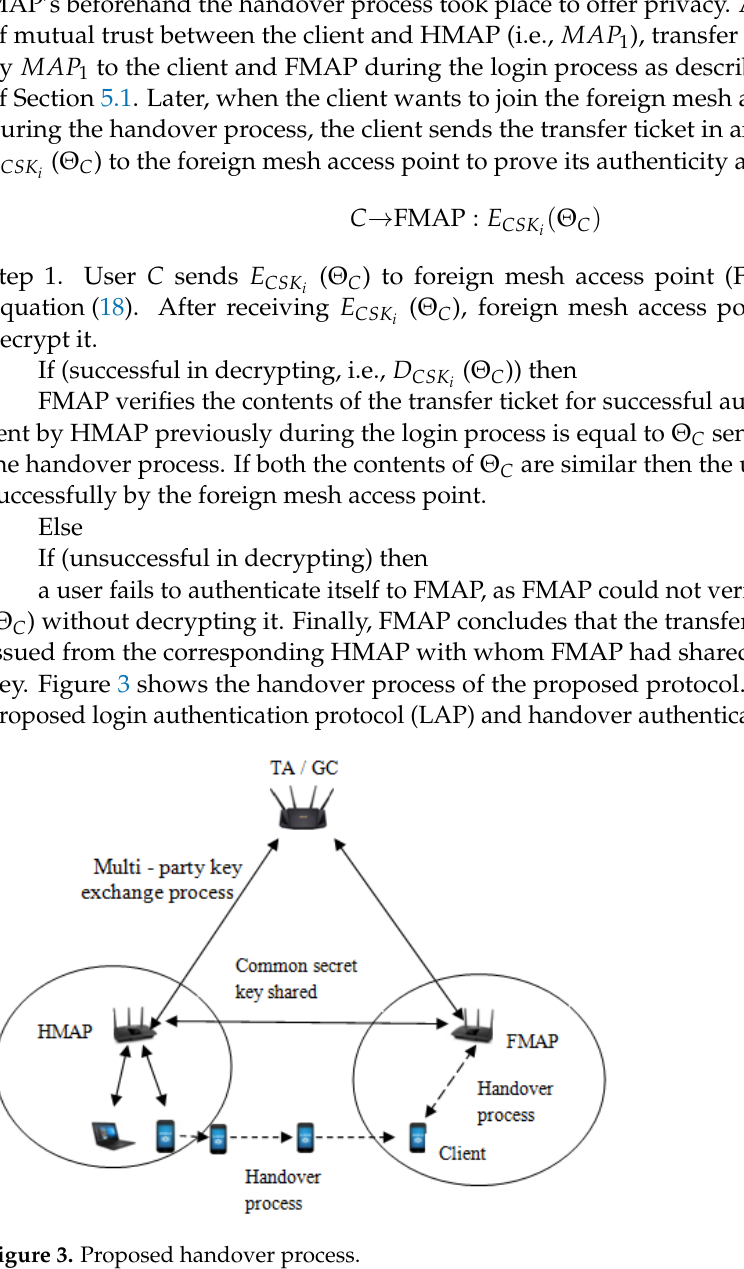
Figure 3. Proposed handover